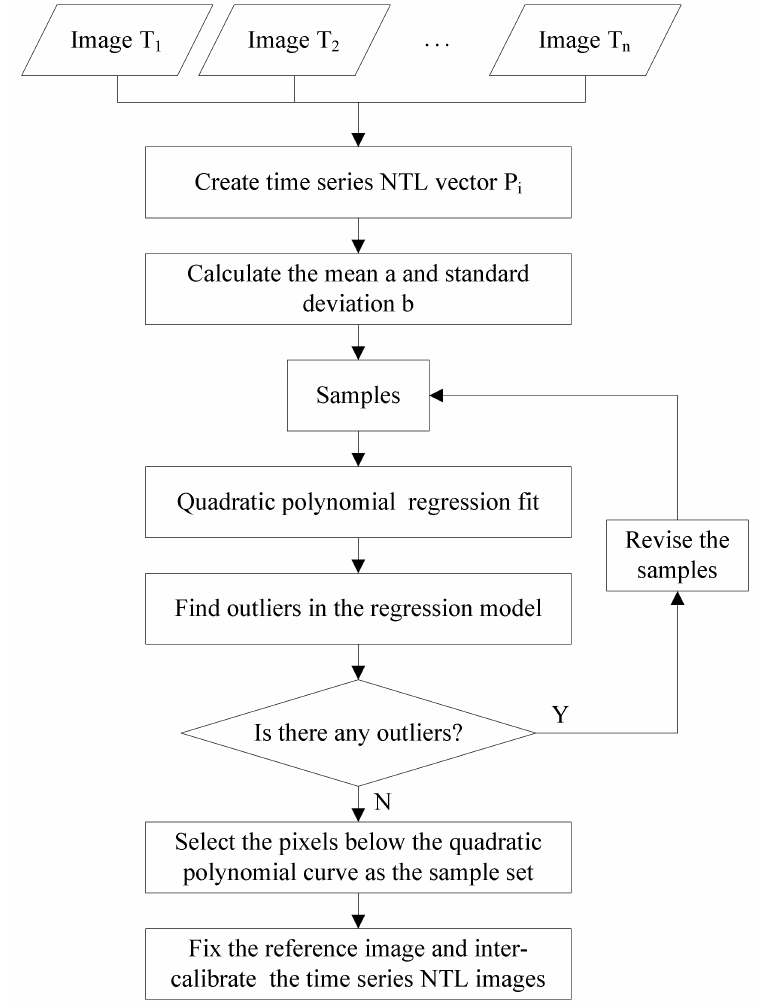
Figure 3. Flowchart of the proposed automatic intercalibration